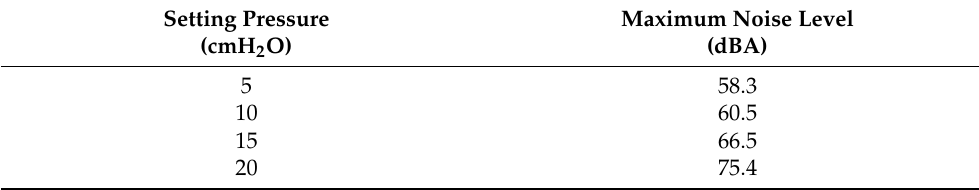
Table 7. Maximum noise level of blower-based ventilator at various setting